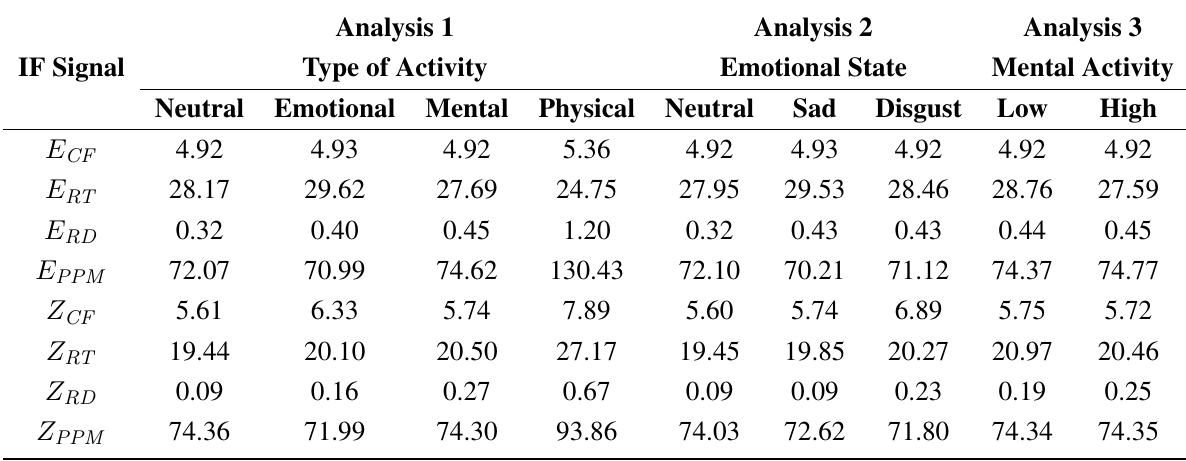
Table 2. Average values for the eight IF signals in the different classes defined in the three analyses: type of activity, emotional state and mental activity.